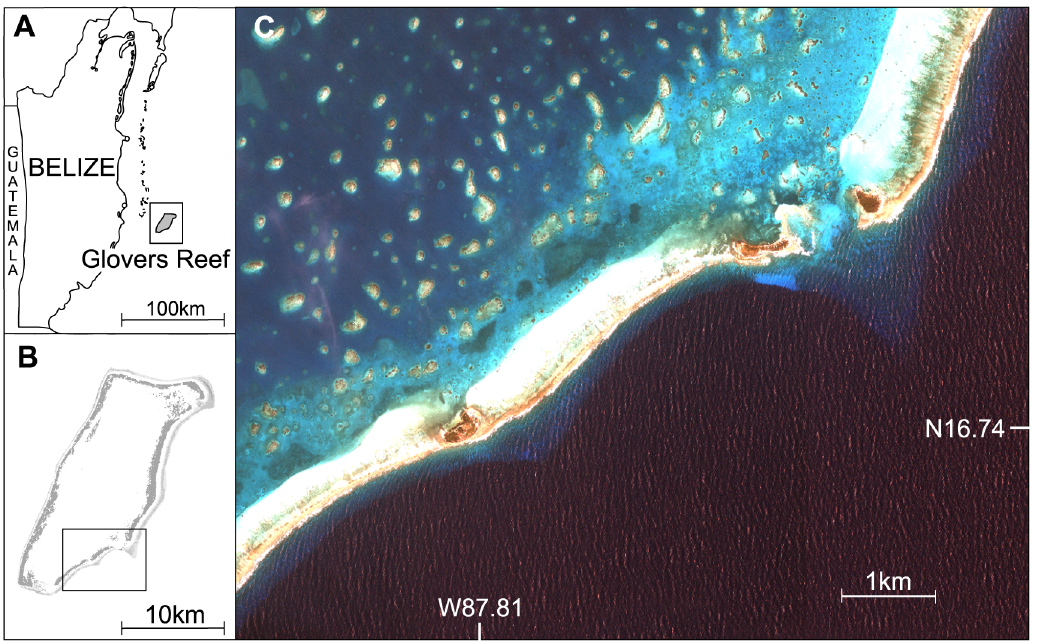
Figure 1. Study site location. (A) Glovers Reef Atoll within Belize, (B) Map of Glovers Reef Atoll, (C) Enlarged satellite image of the main sampling area on Glovers Reef